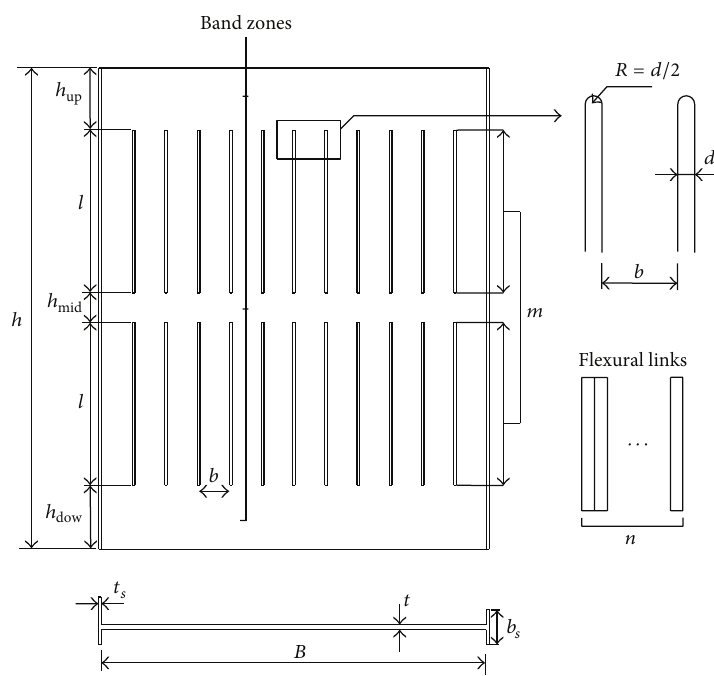
Figure 1: Schematic drawing of steel slit wall.